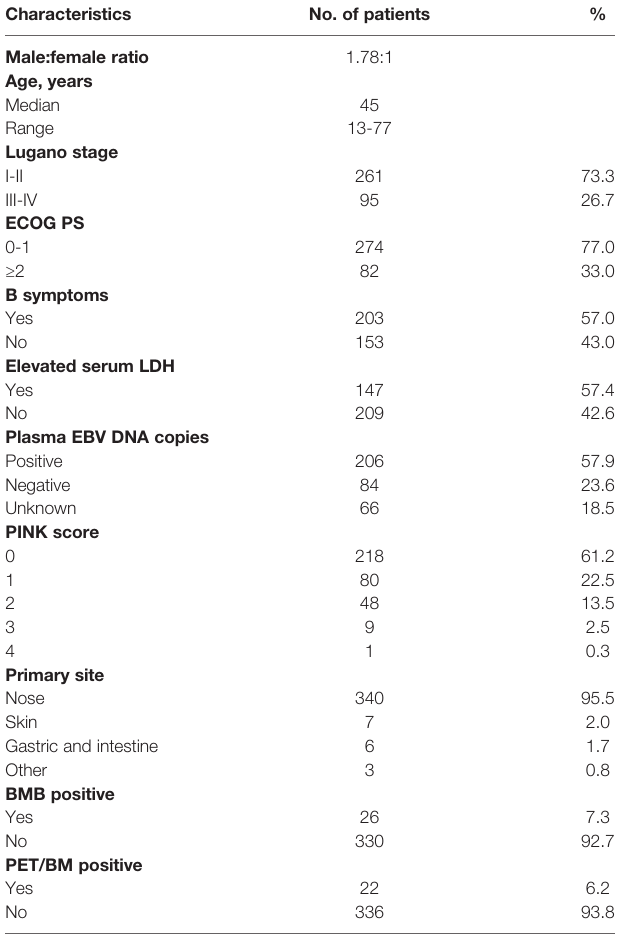
TABLE 1 | Characteristics of ENKTL patients at diagnosis in this study (n =